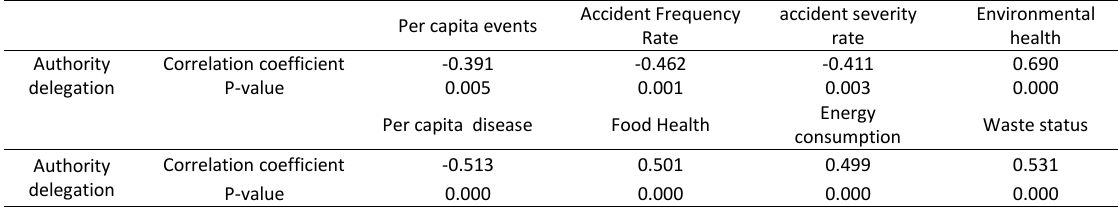
Table 2 Correlation between authority delegation and HSE performance indicators .